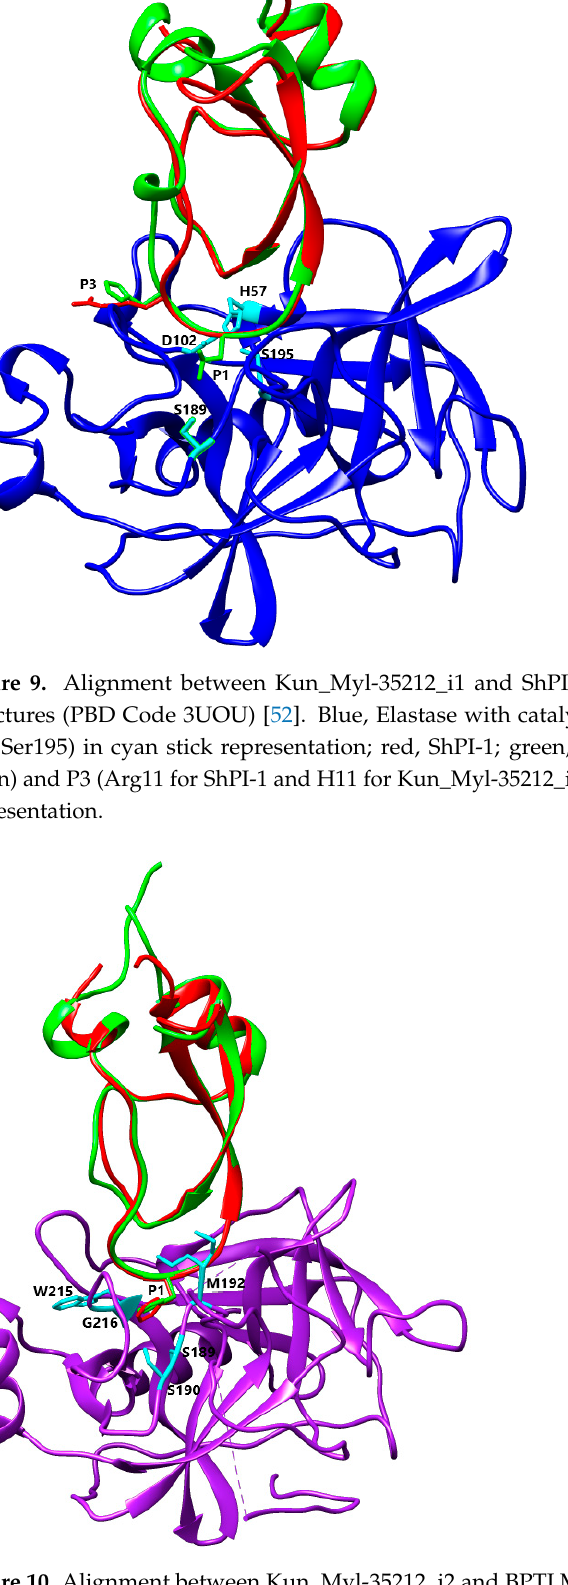
Figure 10. Alignment between Kun_Myl-35212_i2 and BPTI Mutant K15F—Bovine Chymotrypsin Complex (PBD Code 1P2Q) [55]. Purple, Chymotrypsin with S1 pocket walls residues (Ser189, Ser190, Met192, Trp215, and Gly216) in cyan stick representation; red, BPTI Mutant Lys15Phe; green Kun_Myl-35212_i2 with P1 (Phe24) in stick representation.